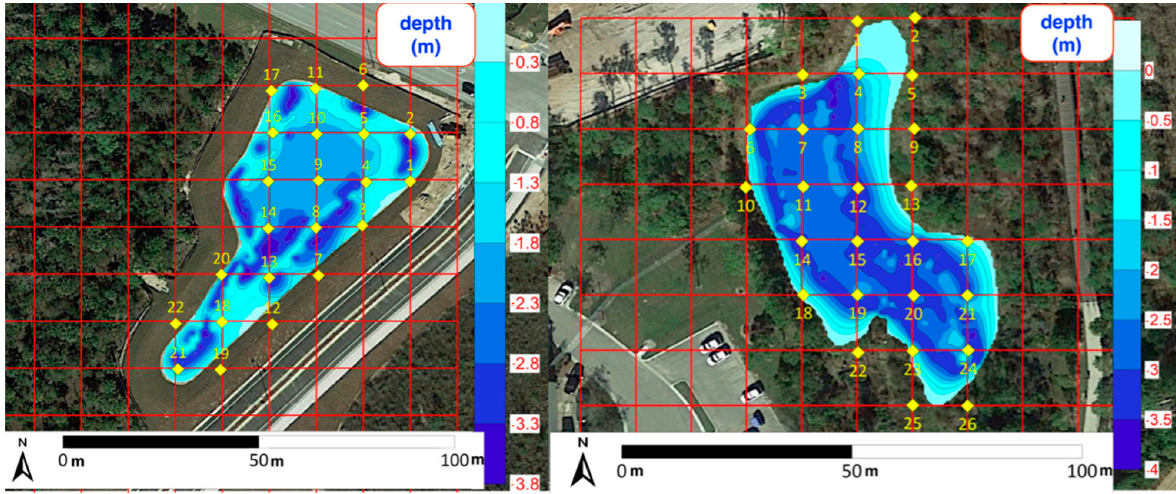
Figure 3. Depth variation and core locations in the SOVI ( left ) and Police ( right ) Ponds. Locations are approximate. Samples sites shown near the pond edges were taken in the pond in fully saturated conditions. Certain sites (such as 1 and 23) were rocky and could not be sampled.